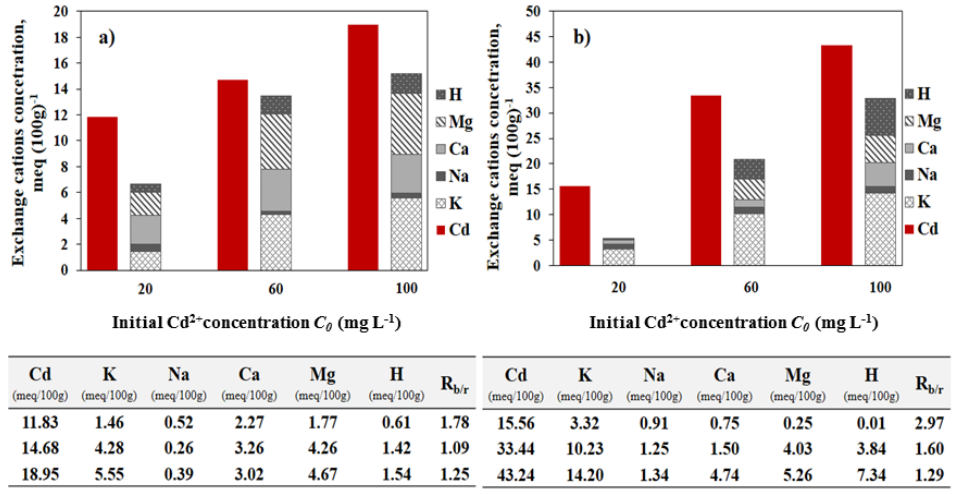
Figure 6. The amount of adsorbed Cd 2+ and released K + , Na + , Ca 2+ , Mg 2+ and H + from CS ( a ) and MCS ( b ) during adsorption process.